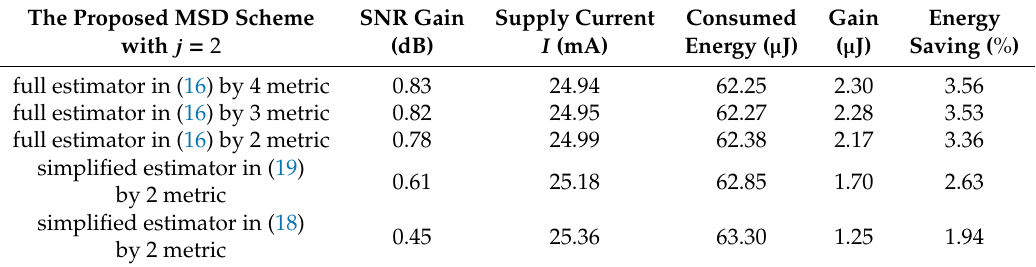
Table 3. At PER = 1 × 10 − 2 , supply current for transmission and transmission energy gain achieved by the proposed MSD scheme in the sink node over the normalized slow Rayleigh fading